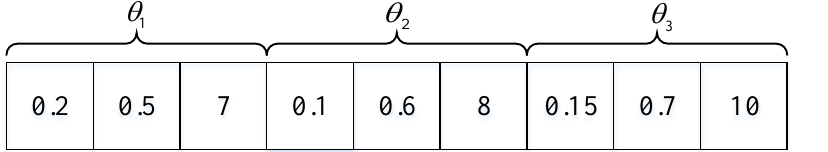
Figure 3. The position of the k -th